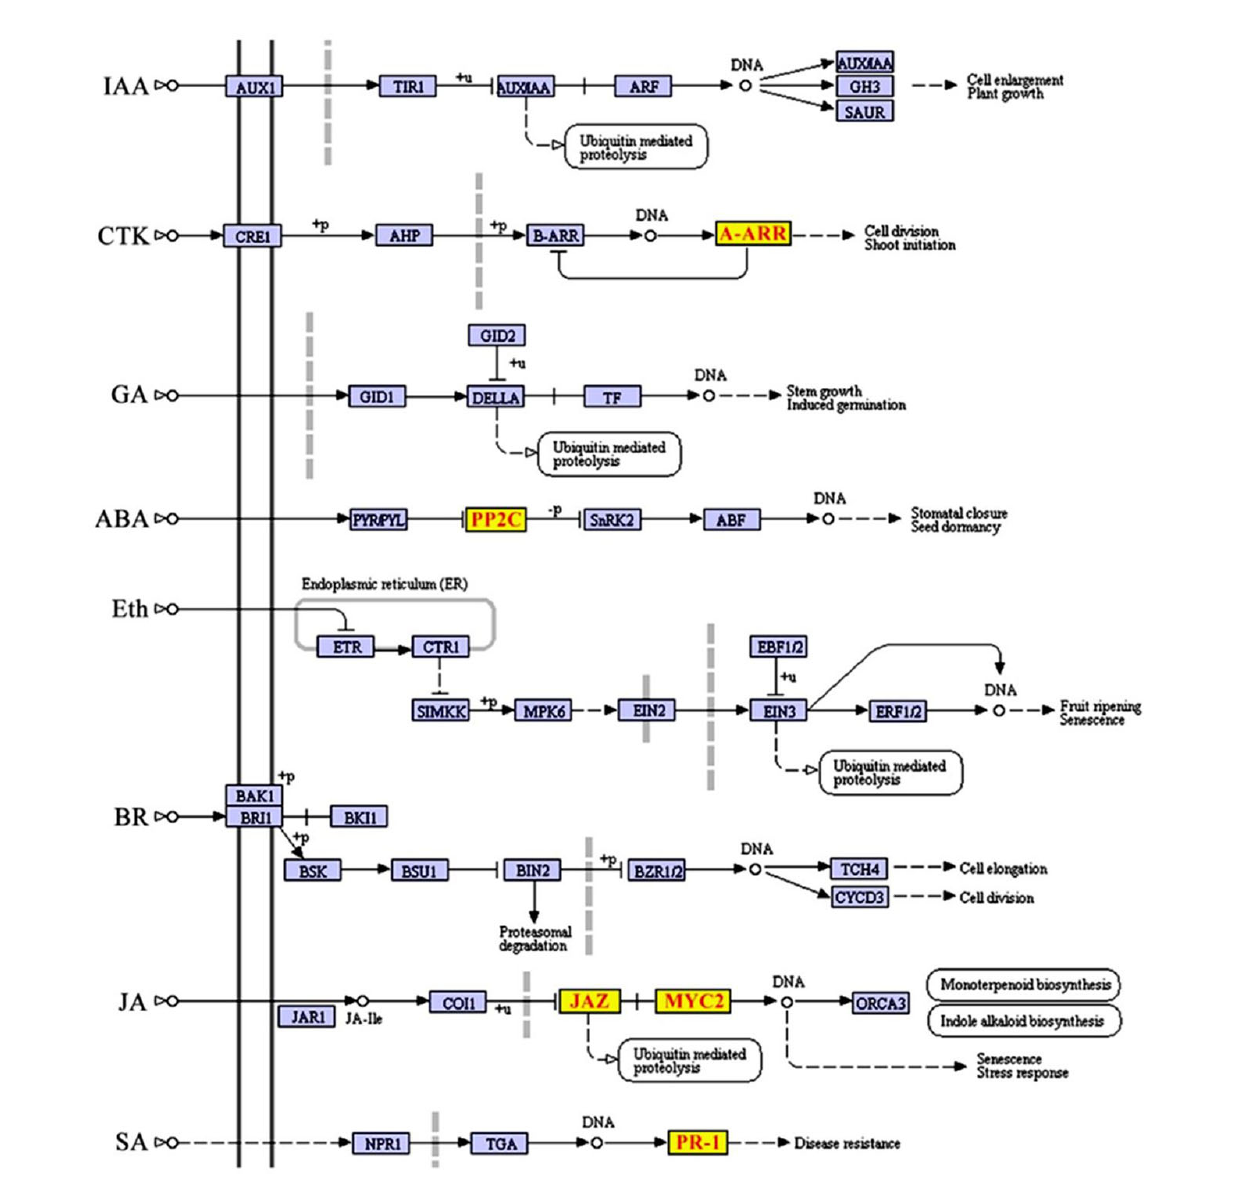
FIGURE 3 | Differentially expressed genes (DEGs) mapped to the plant hormone signal transduction pathway according to a Kyoto Encyclopedia of Genes and Genomes (KEGG) enrichment analysis. KEGG terms with a corrected P -value less than 0.05 were considered to be signi fi cantly enriched by DEGs. Five DEGs, comprising JAZ , MYC2 , ARR-A , PR1 , and PP2C , were screened and transcript levels were upregulated, which are shown in red letters on yellow blocks in the plant hormone signal transduction